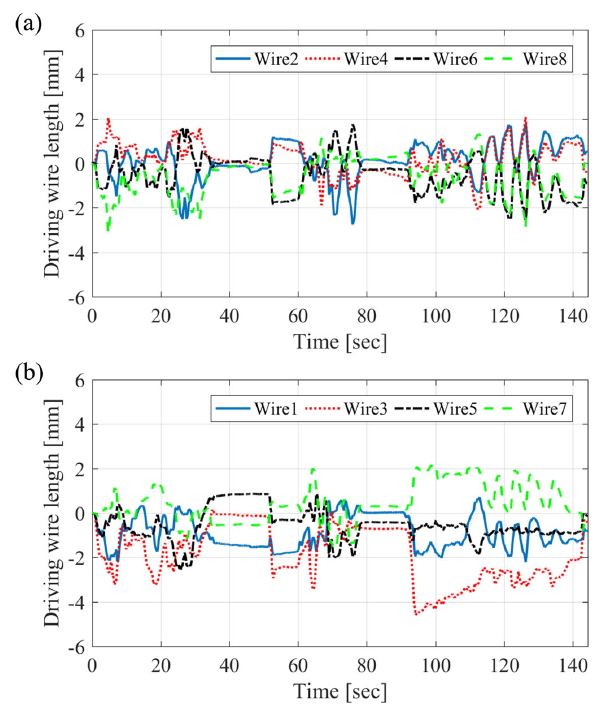
Figure 19. Driving wire length from the path generator with the Jacobian matrix and PID control algorithm for ( a ) proximal joints and ( b ) distal